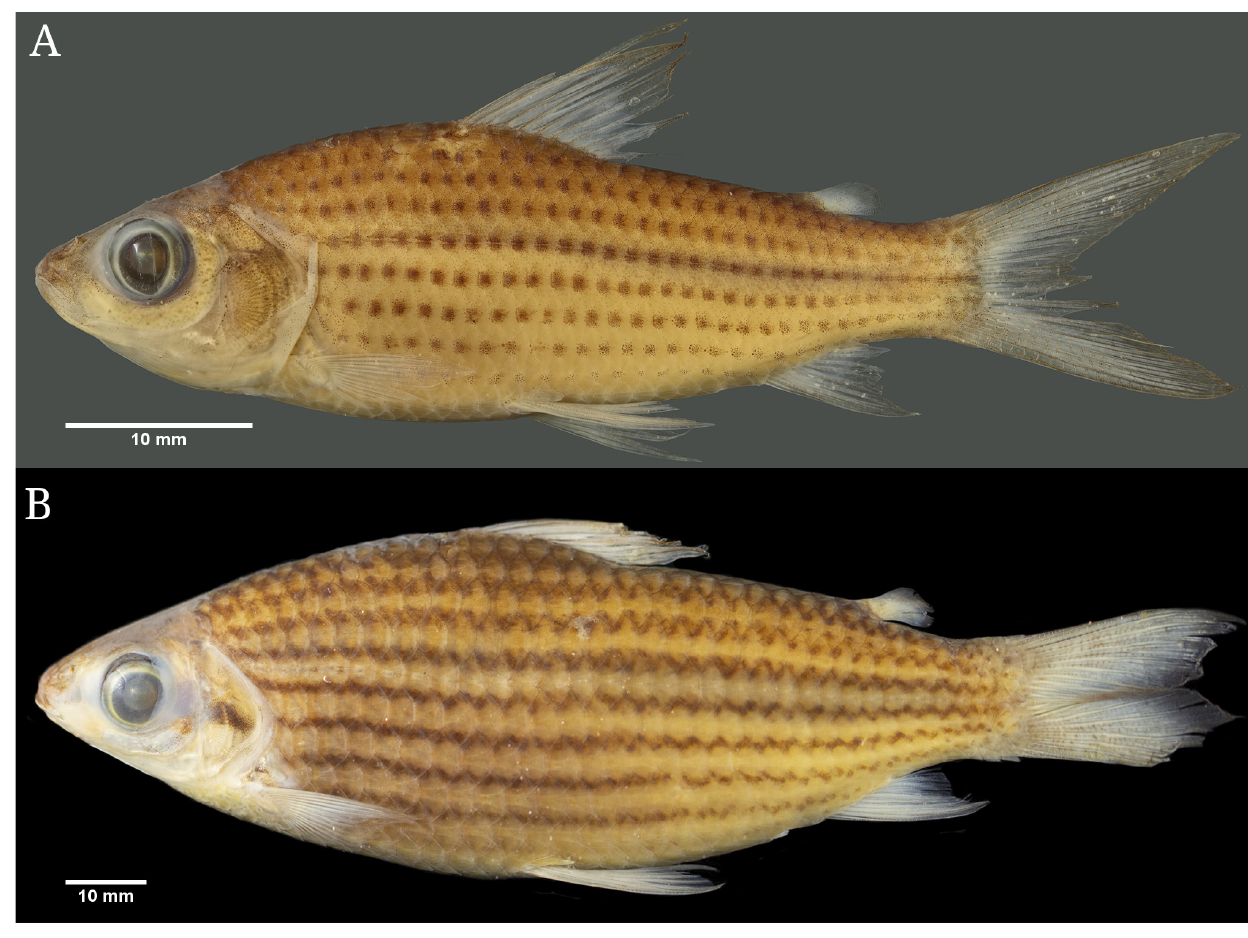
FIGURE 3 | A. Cyphocharax pantostictos , ZUEC 17137, 48.8 mm SL, Peru, Loreto, río Itaya basin; B. Cyphocharax multilineatus , MCP 54223, 116.3 mm SL, Brazil, Pará, Santarém, rio